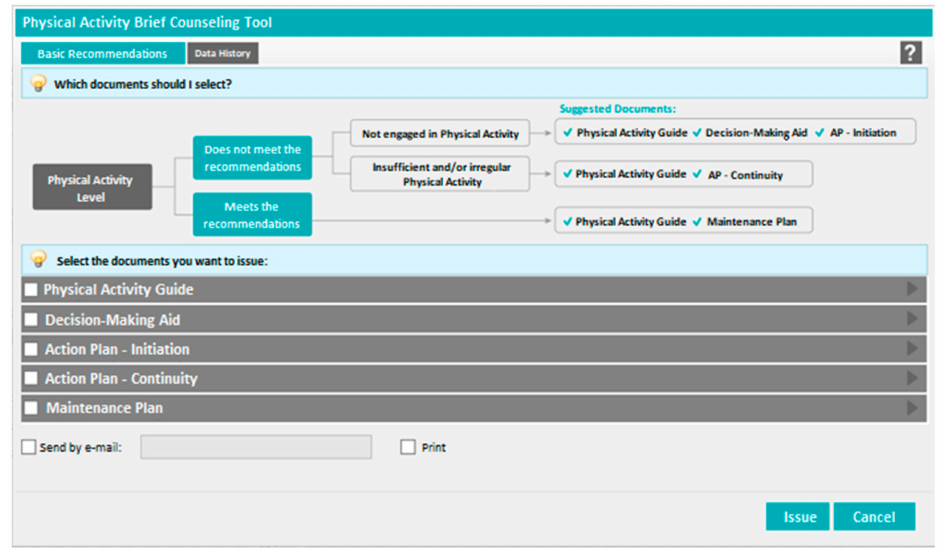
Figure 2. Physical activity brief counseling tool in the software platform “PEM—Prescriç ã o Eletr ó nica M é